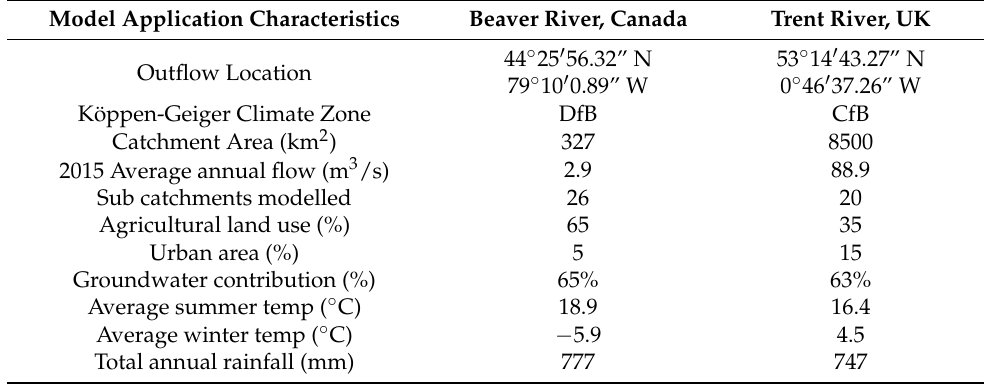
Table 1. Catchment characteristics as represented in INCA PEco. Model Application Characteristics Beaver River, Canada Trent River,